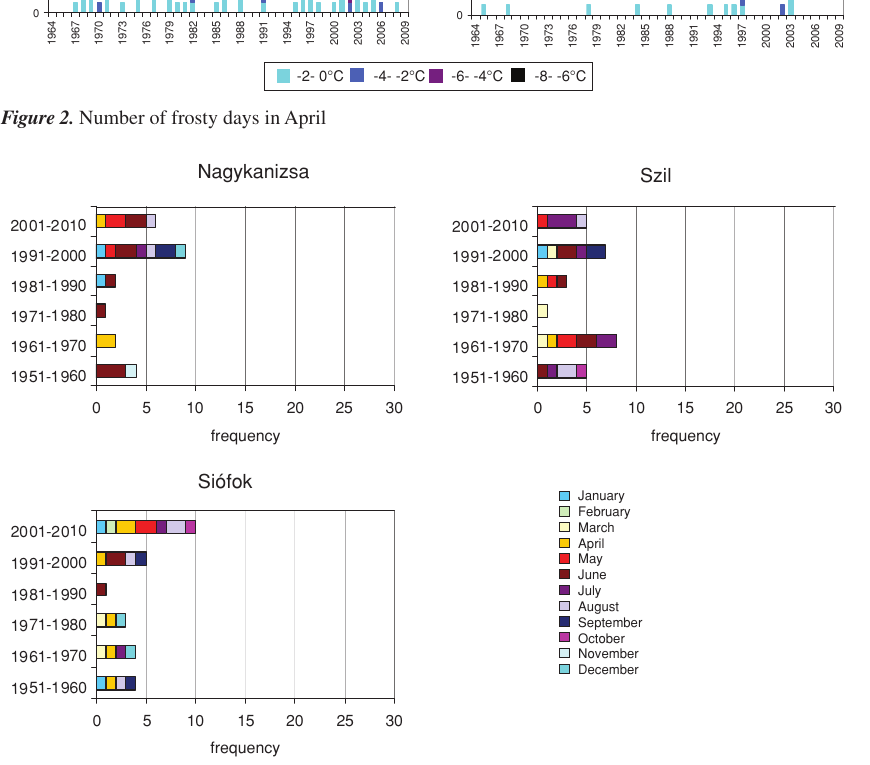
Figure 3. Frequencies of hail events even at -6°C making the production profitable even in the extreme cold years. Nagykanizsa is the worst in the aspect of spring frost because in some years temperatures colder than –6°C occur. Even with frost prevention such cold temperatures possibly cause significant frost damage on sweet and even sour cherry flowers.